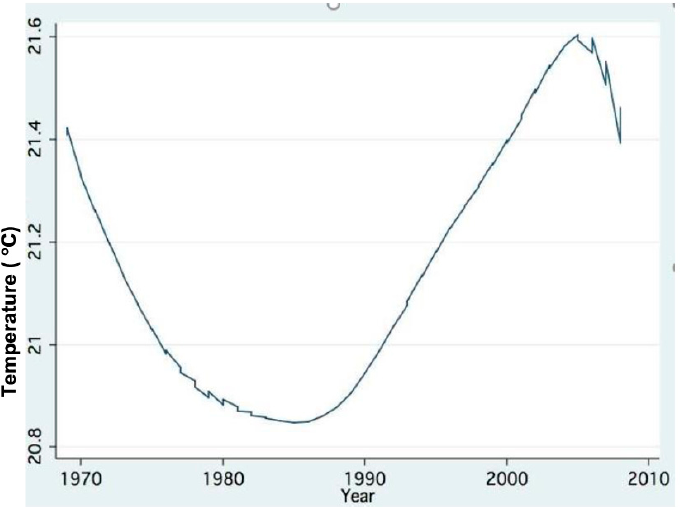
Figure 17. Trend of changes (LOWESS;0.8) of annual means (1969–2008) of Epilimnetic mean tem- perature.